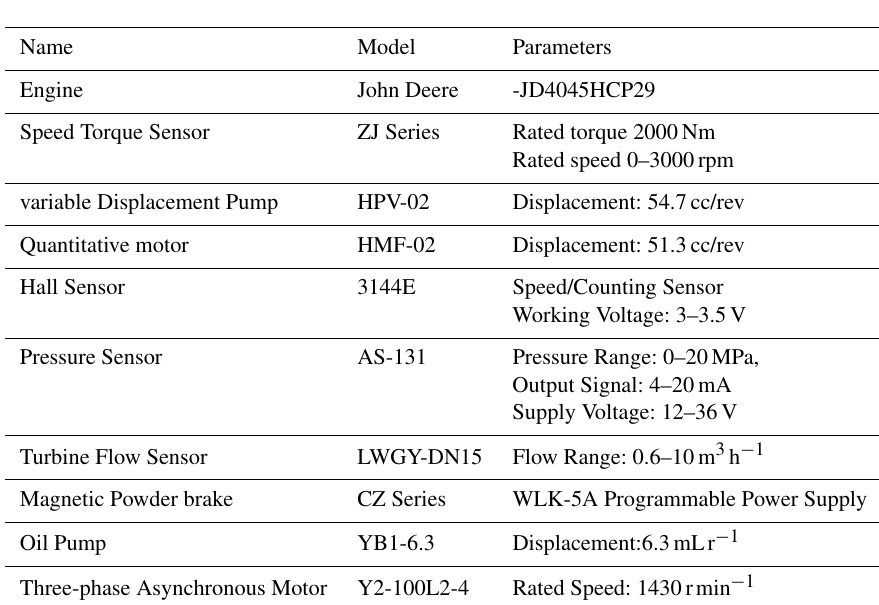
Table 3. HMCVT test bench parameters.